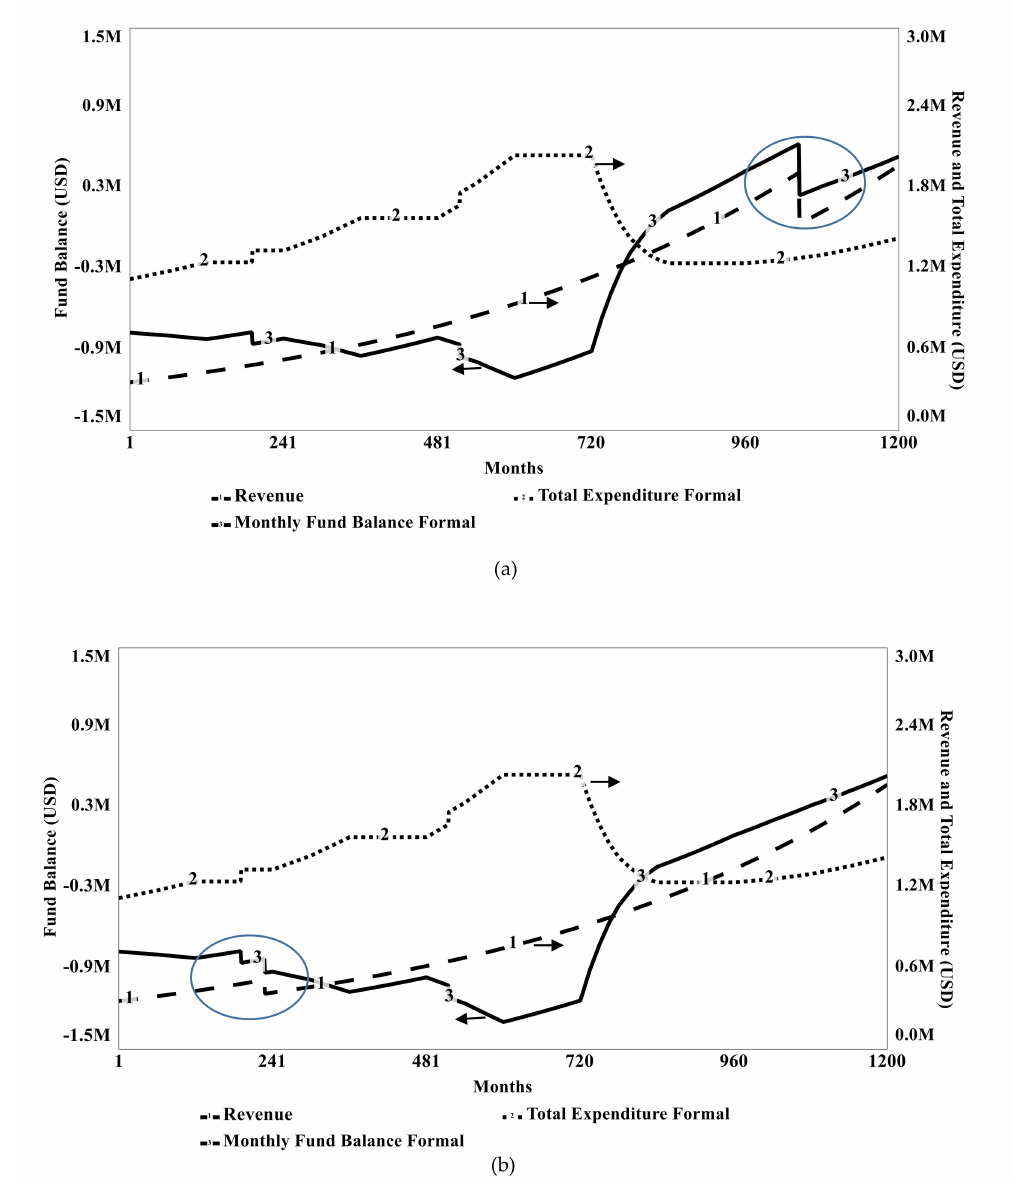
Figure 4. Formal system’s fund balance, revenue and total expenditure (Million USD) under ( a ) informal demand shift resulting from demand supply gap and ( b ) informal demand shift due to HH income change. Circled areas present the decline in revenue due to change in recovery